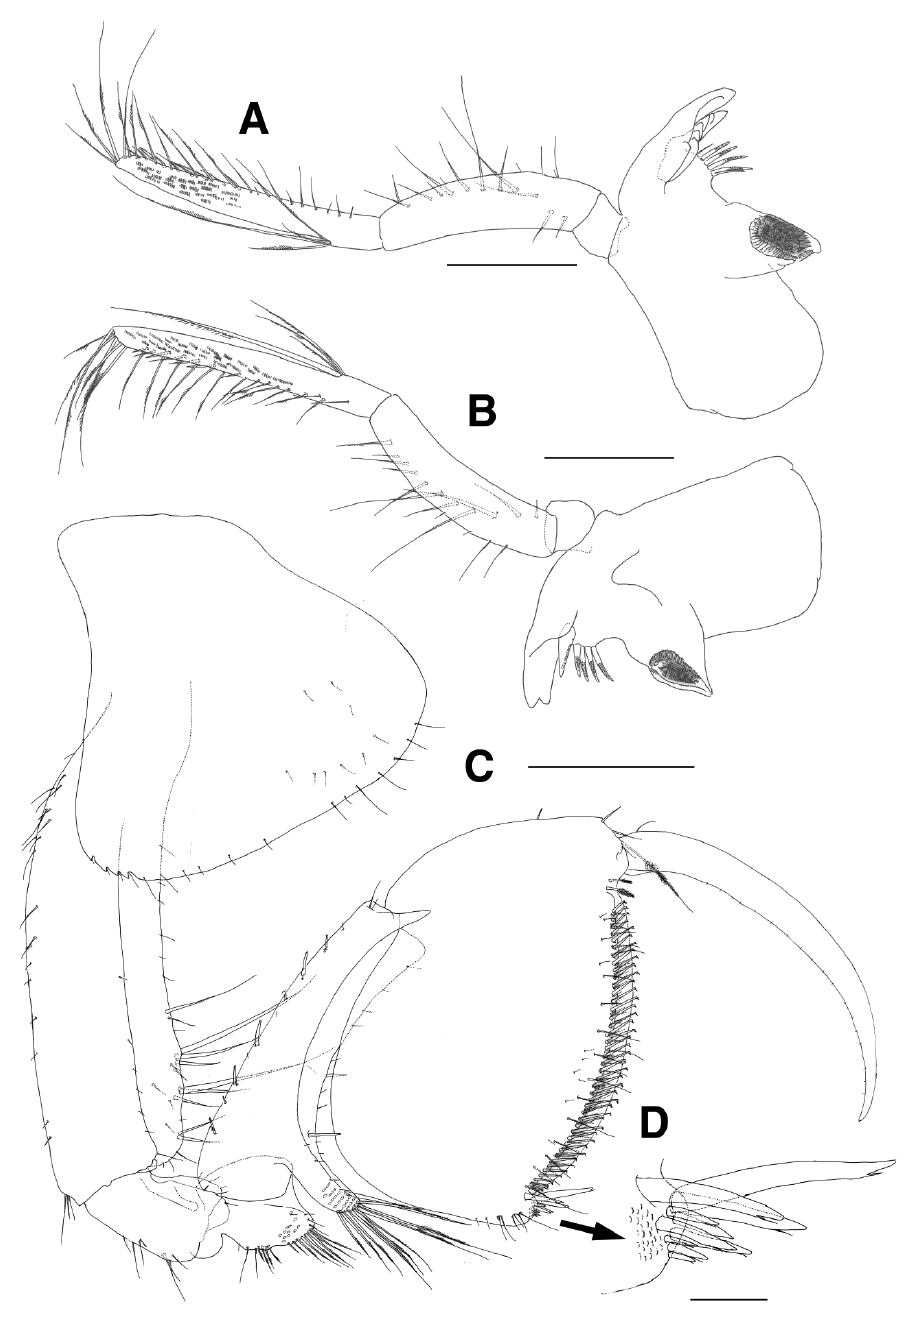
Figure 2. Eusirus bulbodigitus sp. n., holotype, male, NIBRIV0000332003, 11.3 mm. Jeju Island, South Korea. A Left mandible B Right mandible C Gnathopod 1 D Setae of posterior margin of propodus on gnathopod 1. Scale bars=0.05 mm ( D ), 0.4 mm ( C ), 0.5 mm ( A, B